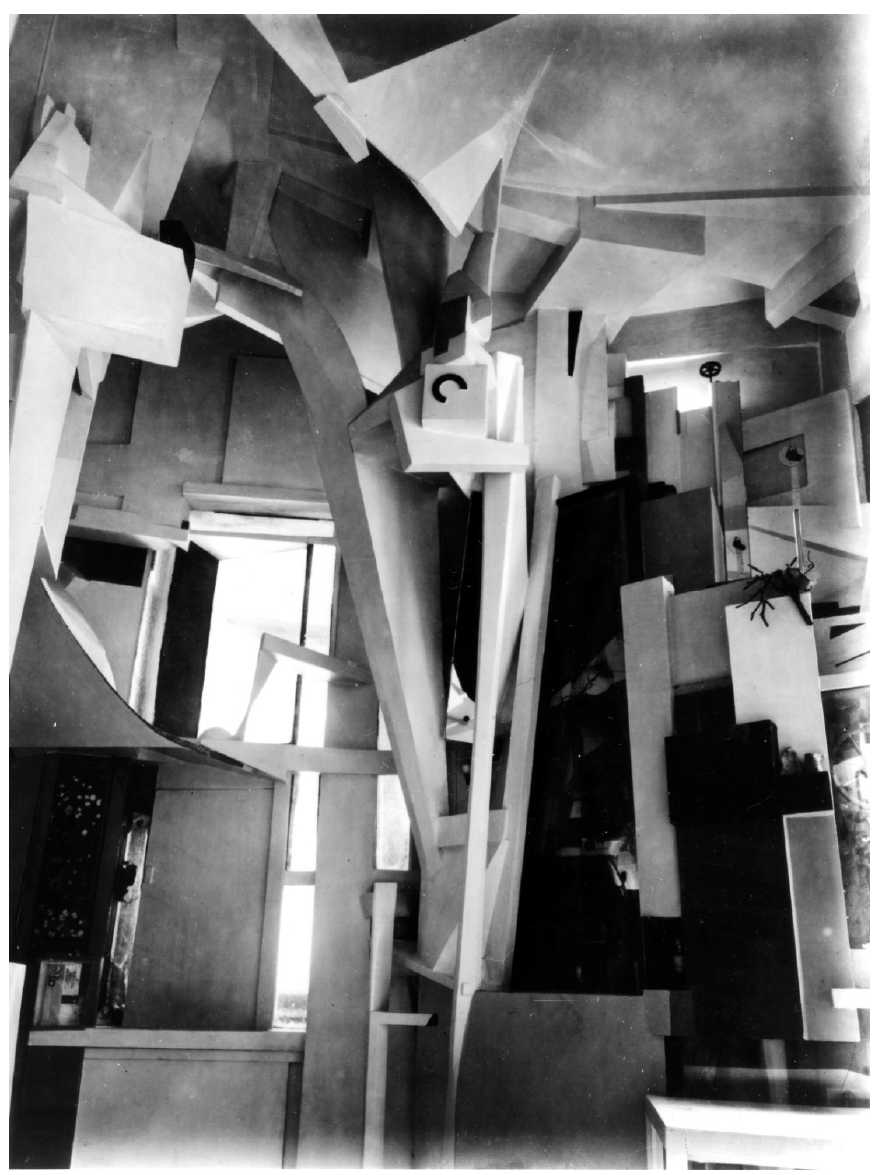
Figure 6. Photograph of Kurt Schwitters’ Merzbau Hannover, 1933. Photo Tate © Wilhelm Redemann, 1933.